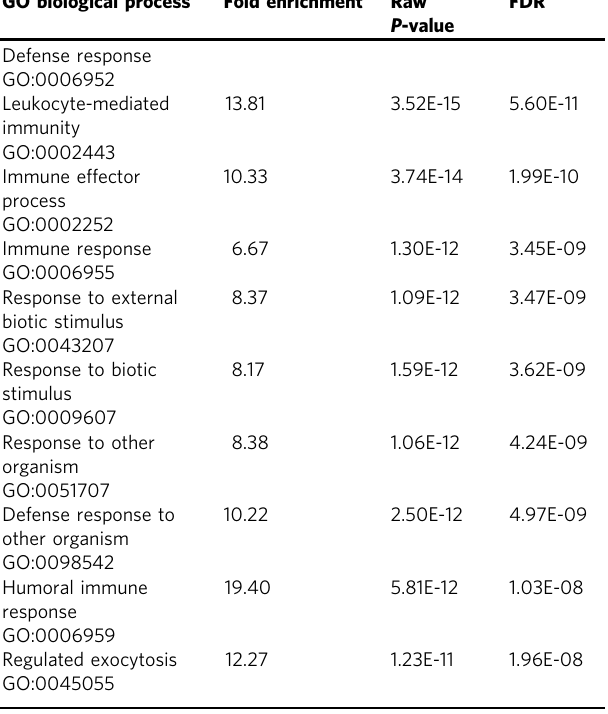
Table 3 Ten most enriched GO biological processes for the PBMC scRNA-seq